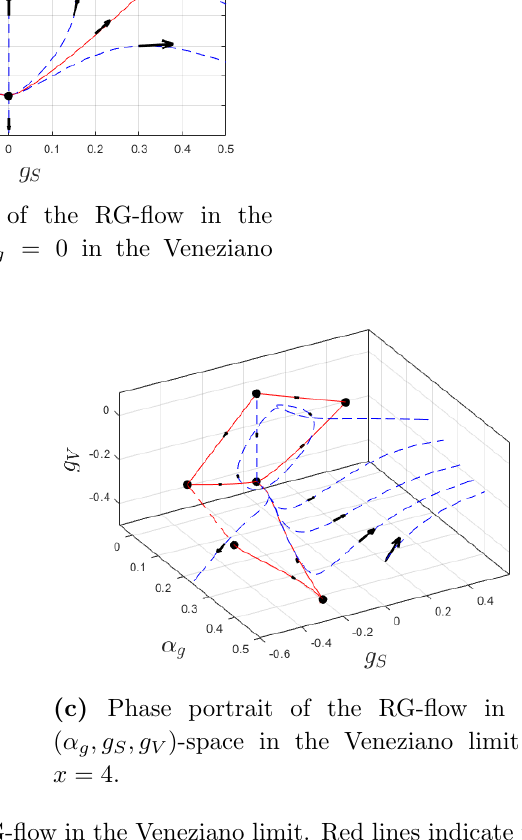
Figure 3. Some characteristic orbits of the RG-(cid:13)ow in the Veneziano limit. Red lines indicate the boundaries of invariant